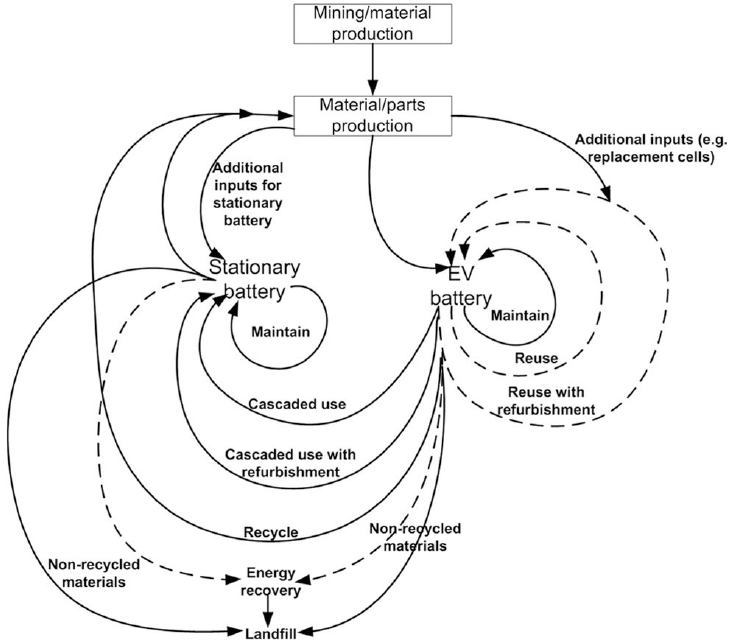
Figure 6. Theoretical waste management hierarchy for retired EV LIBs [96].